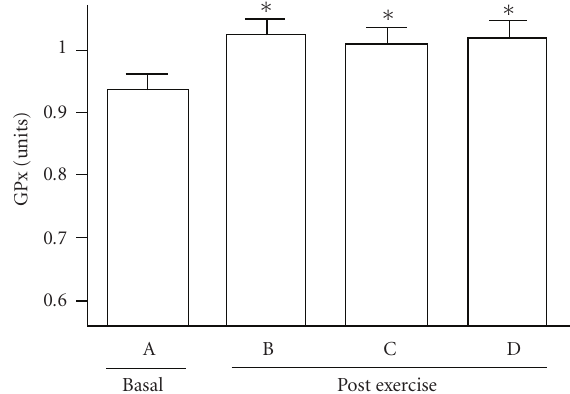
Figure 4: Plasma glutathione peroxidase (GPx) activity during basal (A) and immediately after a continuous progressive exercise test (B), a strenuous test performed until exhaustion (C) and a submaximalexercise (70% of the expected maximumworkload) for 30 minutes (D). n = 34. Data is expressed as mean ± standard error. ∗ denotes statistical di ff erences ( P < . 05) versus A.